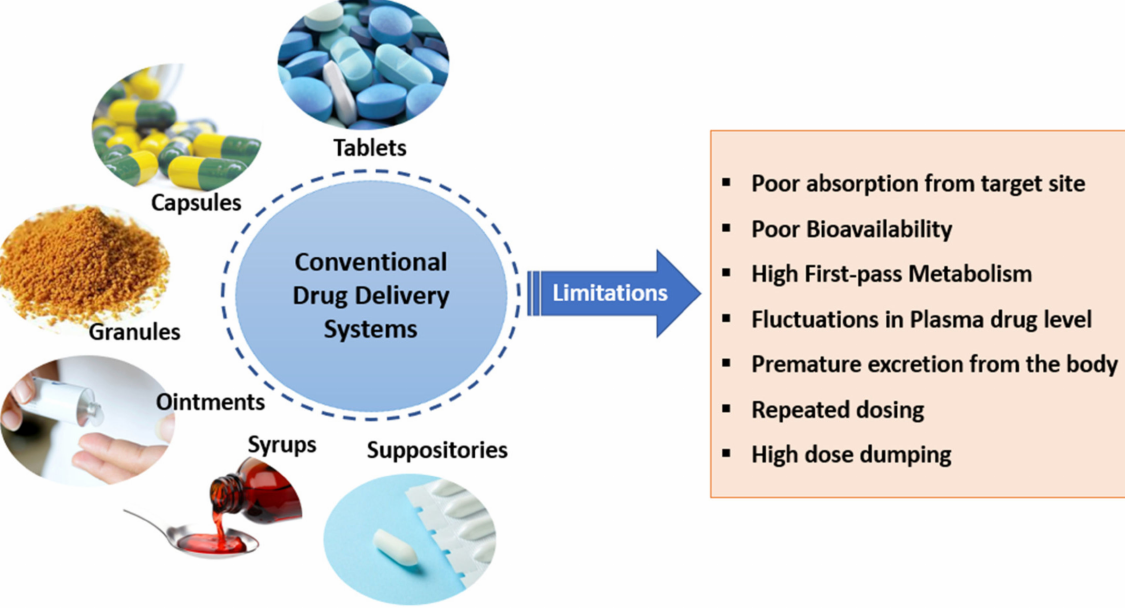
Figure 19. Limitations of Conventional drug delivery systems. Sustained Drug Delivery System Sustained-release drug delivery systems achieve the slow release of a drug over an extended period after administration of a single